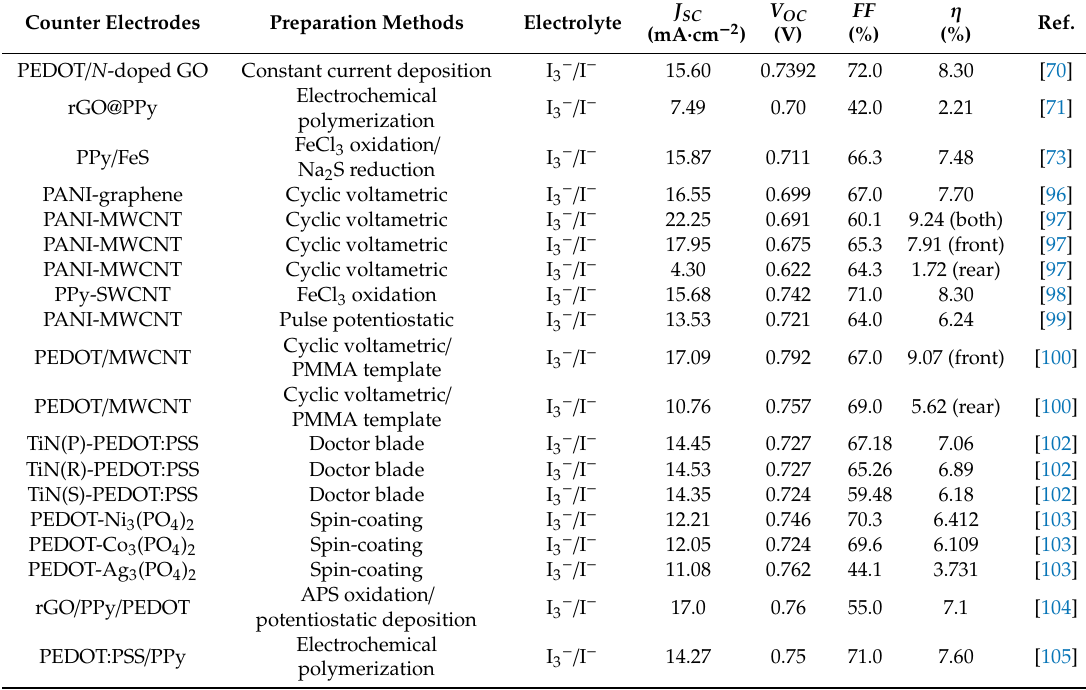
Table 4. Photovoltaic performances parameters of DSSCs assembled with conductive polymers-based hybrids counter